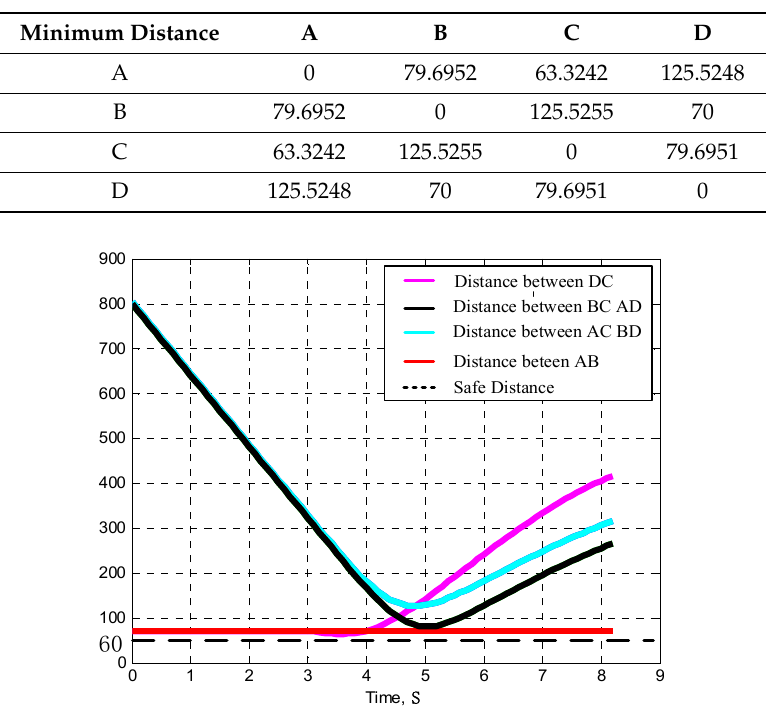
Table 11 records the initial state of the eight aircraft.